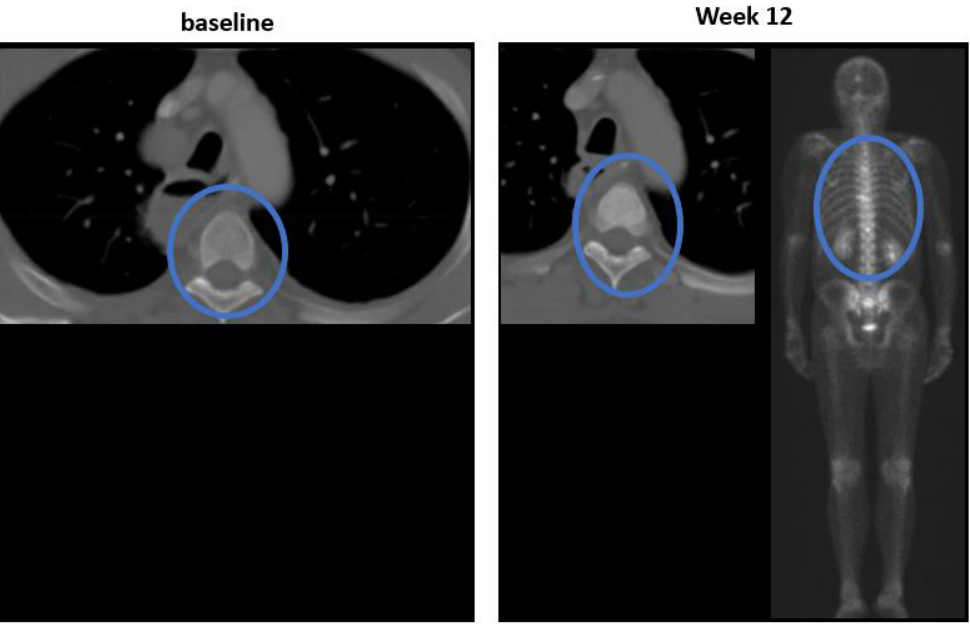
Figure 5. New sclerotic lesions. Newly appearing sclerotic lesions in the CT and uptakes in the bone scan in week 12, but with no evidence of lesions at baseline (marked in blue circles).